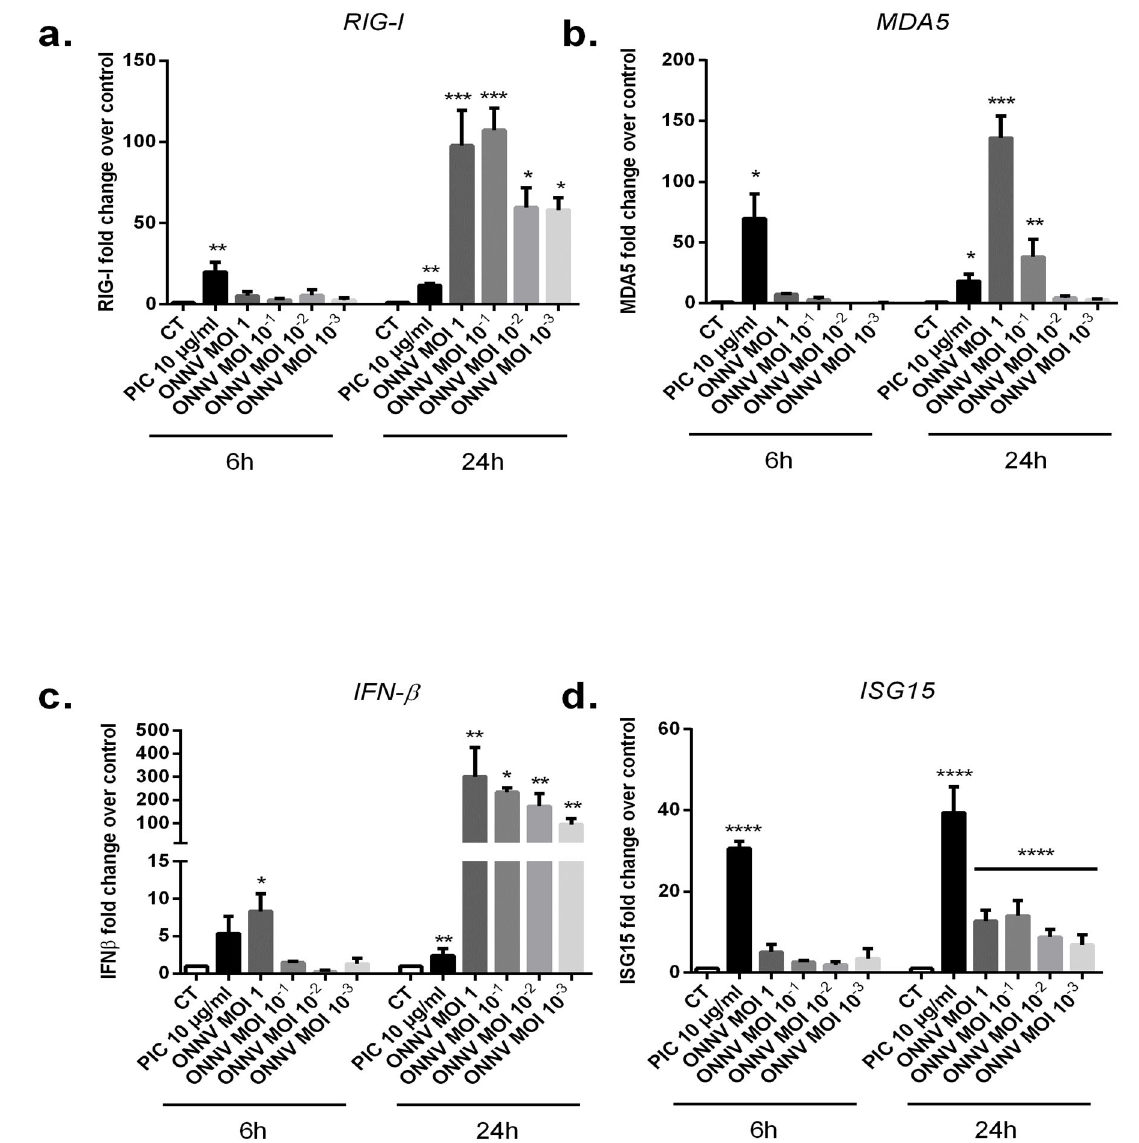
Figure 4. Canonical antiviral innate immune genes are markedly upregulated in ONNV ‐ infected SC. ( a ) RIG ‐ I, ( b ) MDA5, ( c ) IFN ‐β , and ( d ) ISG15 mRNA levels were quantified by qRT ‐ PCR in SC after ONNV (from MOI 10 − 3 to 1) infection or exposure to PIC 10 μ g/mL for 6 h and 24 h. All experiments were done in triplicates. Results are expressed as mean ± SEM and presented as a normalized fold increase vs. control (CT). * p ‐ values ≤ 0.05, ** p ‐ values ≤ 0.01, *** p ‐ values ≤ 0.001, and **** p ‐ values ≤ 0.0001 represent significant differences from controls by one ‐ way ANOVA followed by the Bonferroni’s test analysis.